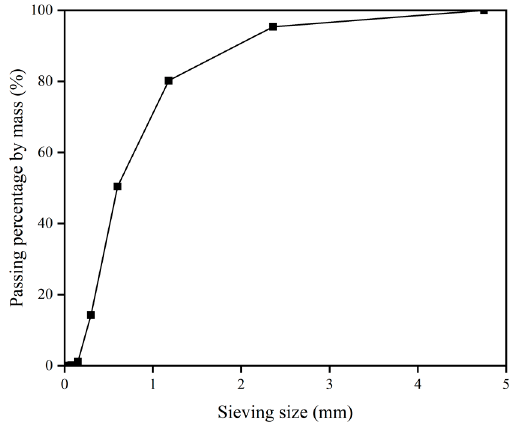
Figure 1. Particle size distribution curves of manufactured sand.